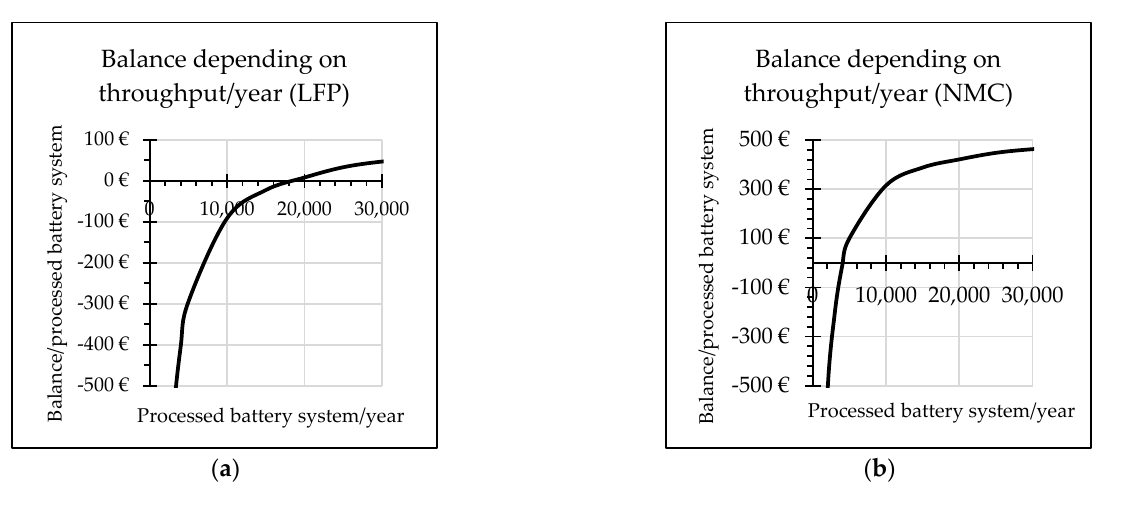
Figure 15. Sensitivity analysis: influence of throughput per year of retired EVs on the cost – benefit- balance for ( a ) LFP cathodes and ( b ) NMC cathodes.